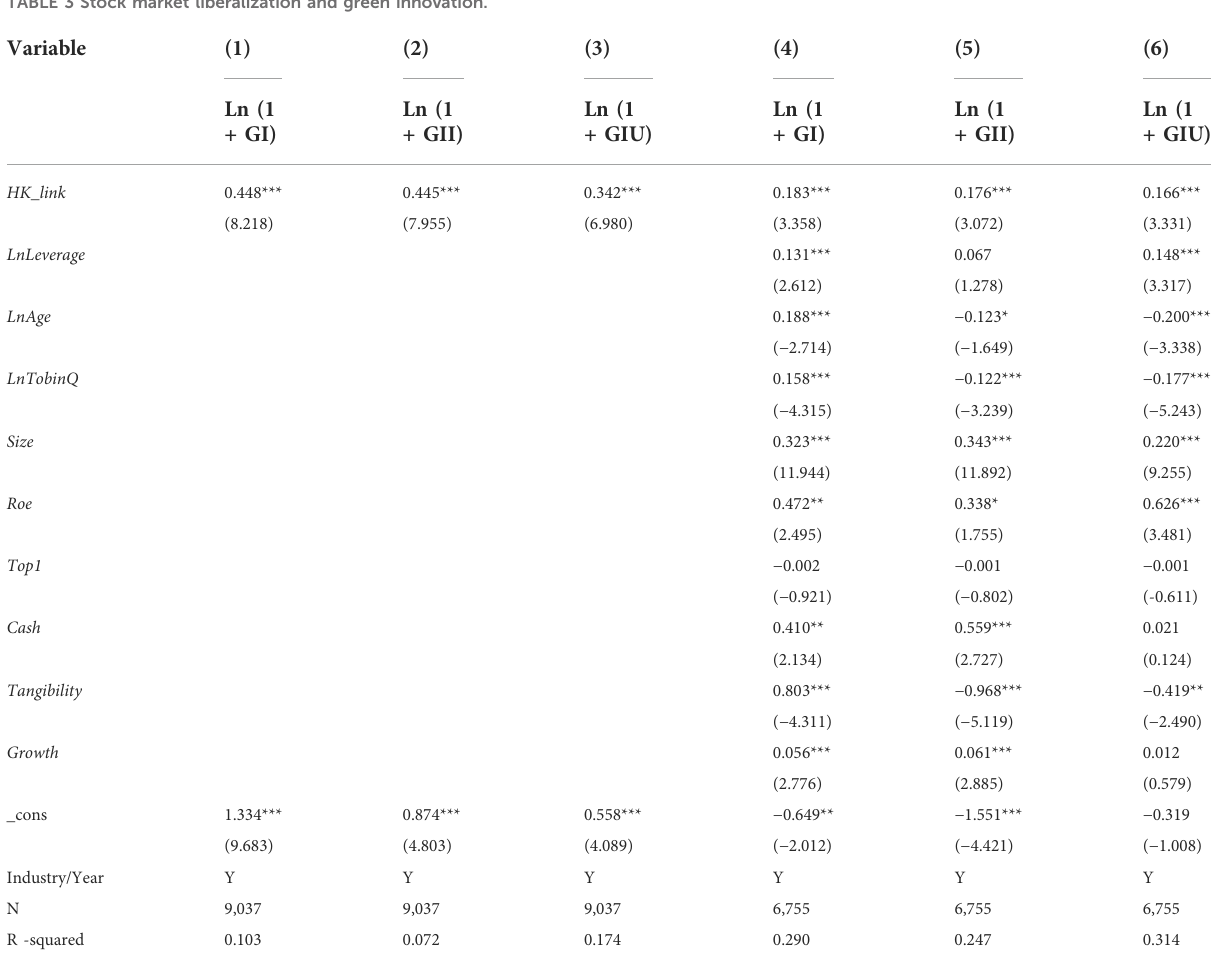
TABLE 3 Stock market liberalization and green innovation.